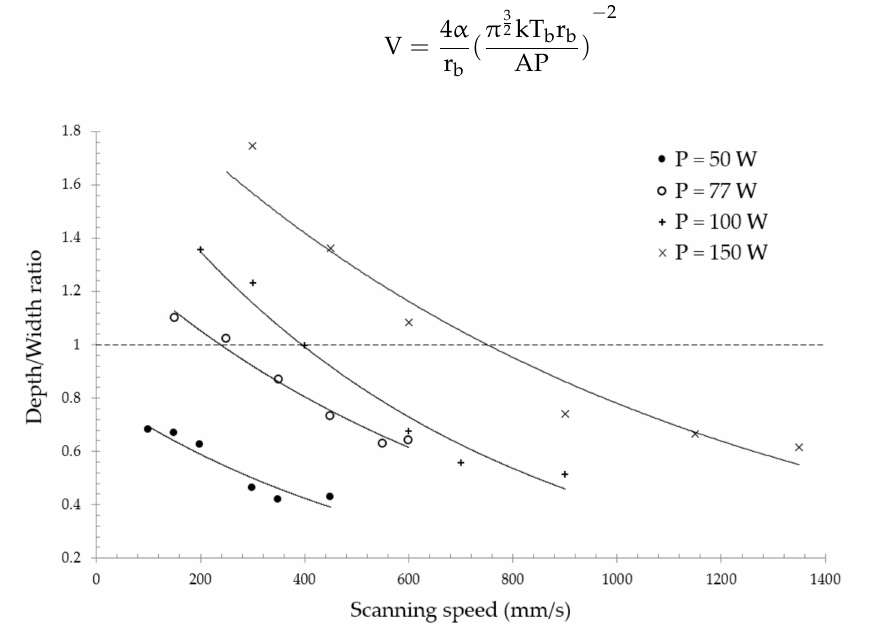
Figure 9. The depth-to-width aspect ratio for the experimentally obtained single tracks. A flexible double-ellipsoidal heat source (Section 3.2) was chosen for the obtained experimental data, since the cross-sections of the single tracks had both sharp and spherical shapes. The process conditions of the experiment described earlier were used for the FE simulations. The volumetric heat source was calibrated with the obtained experimental data, and the calculated temperature field for P = 100 W and V = 400 mm/s is demonstrated in Figure 10. The transverse cross-section (Figure 10a) and top view (Figure 10b) were com- pared with experimental images obtained from single tracks. The longitudinal cross-section (Figure 10c) reveals the difference in the melt pool depth in the front and rear parts. Com- pared to the experimentally measured single tracks’ width and depth, the overall simulation results are shown in Figure 11. Good agreement of the results confirms the effectiveness of the calibration method used in this study. Still, the implementation of the proposed model requires experimental data for calibration, and the result of calibration depends on many conditions, such as laser power density distribution, laser spot size, chemical composition of the material, powder particle size distribution, etc. However, the proposed model has its advantages—simplicity in implementation, speed of calculations, fewer required thermal physical properties for the material, and high agreement with the experimental results. The author of [46] showed that an FE model based on isotropic thermal conductivity with a well-calibrated double-ellipsoid heat source provides a maximum deviation of 7.3% from the experimental data. Furthermore, Kollmannsberger et al. proposed improvements of the experiment-based FE models by introducing anisotropic conductivities to address the contribution of thermal convection in the melt pool discussed